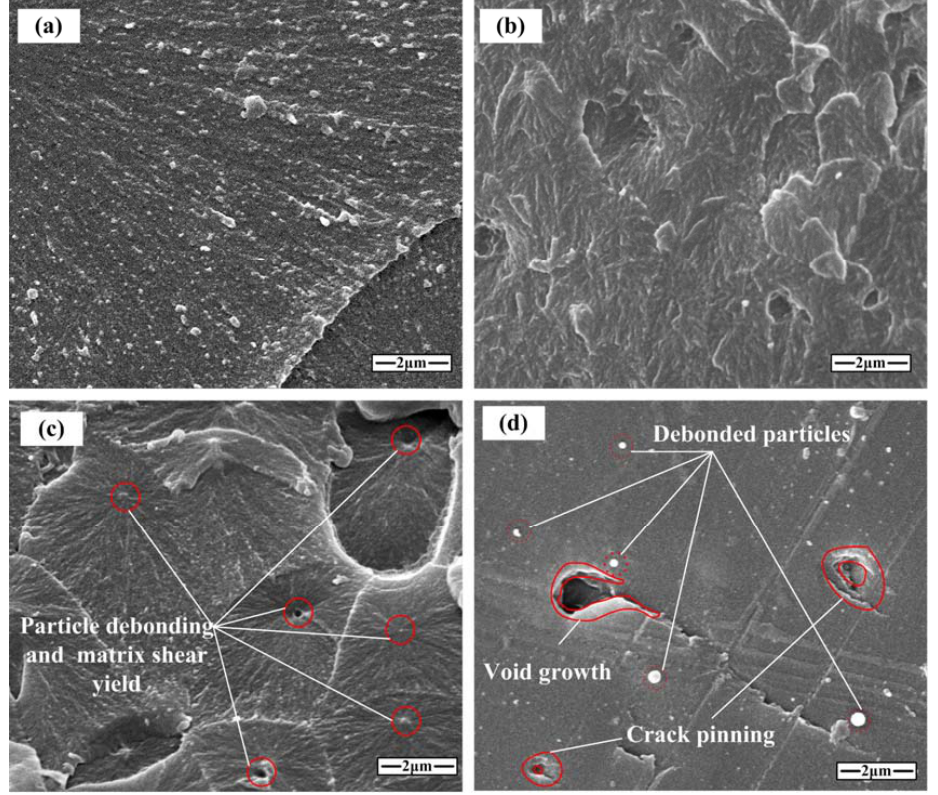
Figure15. SEM micrographs of the dynamic fracture surface ( a ) neat epoxy; ( b ) 50 nm Al 2 O 3 ‐ filled epoxy (3 wt %); ( c ) 100 nm Al 2 O 3 ‐ filled epoxy (3 wt %); and ( d ) 200 nm Al 2 O 3 ‐ filled epoxy (3 wt %). epoxy (3 wt %); ( c ) 100 nm Al 2 O 3 -filled epoxy (3 wt %); and ( d ) 200 nm Al 2 O 3 -filled epoxy (3 wt